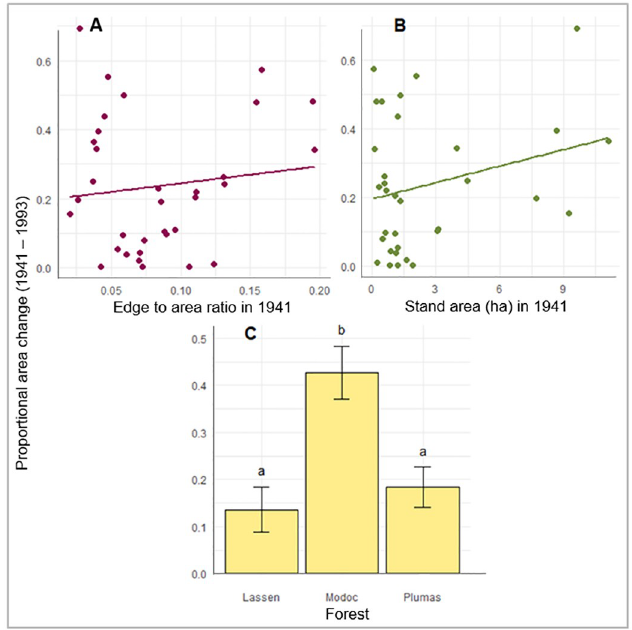
Fig 5. Proportional area change from 1941 to 1993: A) the effect of edge:area ratio in 1941, B) the effect of stand area in 1941 and C) the differences among forests. The plotted dots in A and B are the observed relationship between the two variables, and the lines represent expected area change across range of predictor variable while other variables are held constant at their mean value. The bar graph in C was graphed with pairwise comparison values acquired with emmeans. Error bars represent standard error and letters above each category represent the difference among categories, same letters denoting no significant difference.